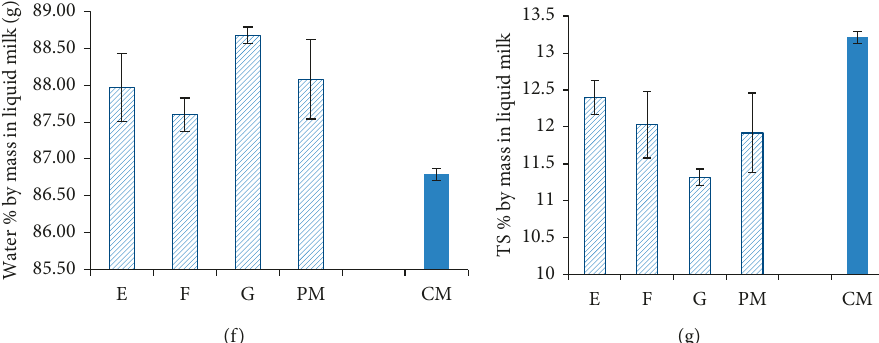
Figure 1: Proximate composition of Sri Lankan-marketed milk: (a) fat in per serving of milk; (b) protein in per serving of milk; (c) ash in per serving of milk; (d) carbohydrate in per serving of milk; (e) moisture % in FCMP; (f) water % in liquid milk; (g) TS % in liquid milk. In Figures 1(a)–1(e), A, B, C, and D are full cream milk brands, and in Figures 1(a)–1(d), 1(f), and 1(g), E, F, and G are pasteurized milk brands. FCMP, PM, and CM represent overall mean of the respective parameter in full cream powder milk, pasteurized milk, and raw cow’s milk. Brandwise comparison was done in between the brands of same types of milk (i.e., between A, B, C, and D). Values of each brand with CM (i.e., protein in SOM of A with CM) and overall mean of the respective parameter in PM and FCMP with CM were compared (i.e., protein in SOM of FCMP with CM). p 0 . 05 is considered as significant. < Table 1: Physicochemical parameters of imported and local FCMP brands. Imported Local Parameter brands brands Fat (g) in SOM by mass Protein (g) in SOM by mass Carbohydrate (g) in SOM by mass